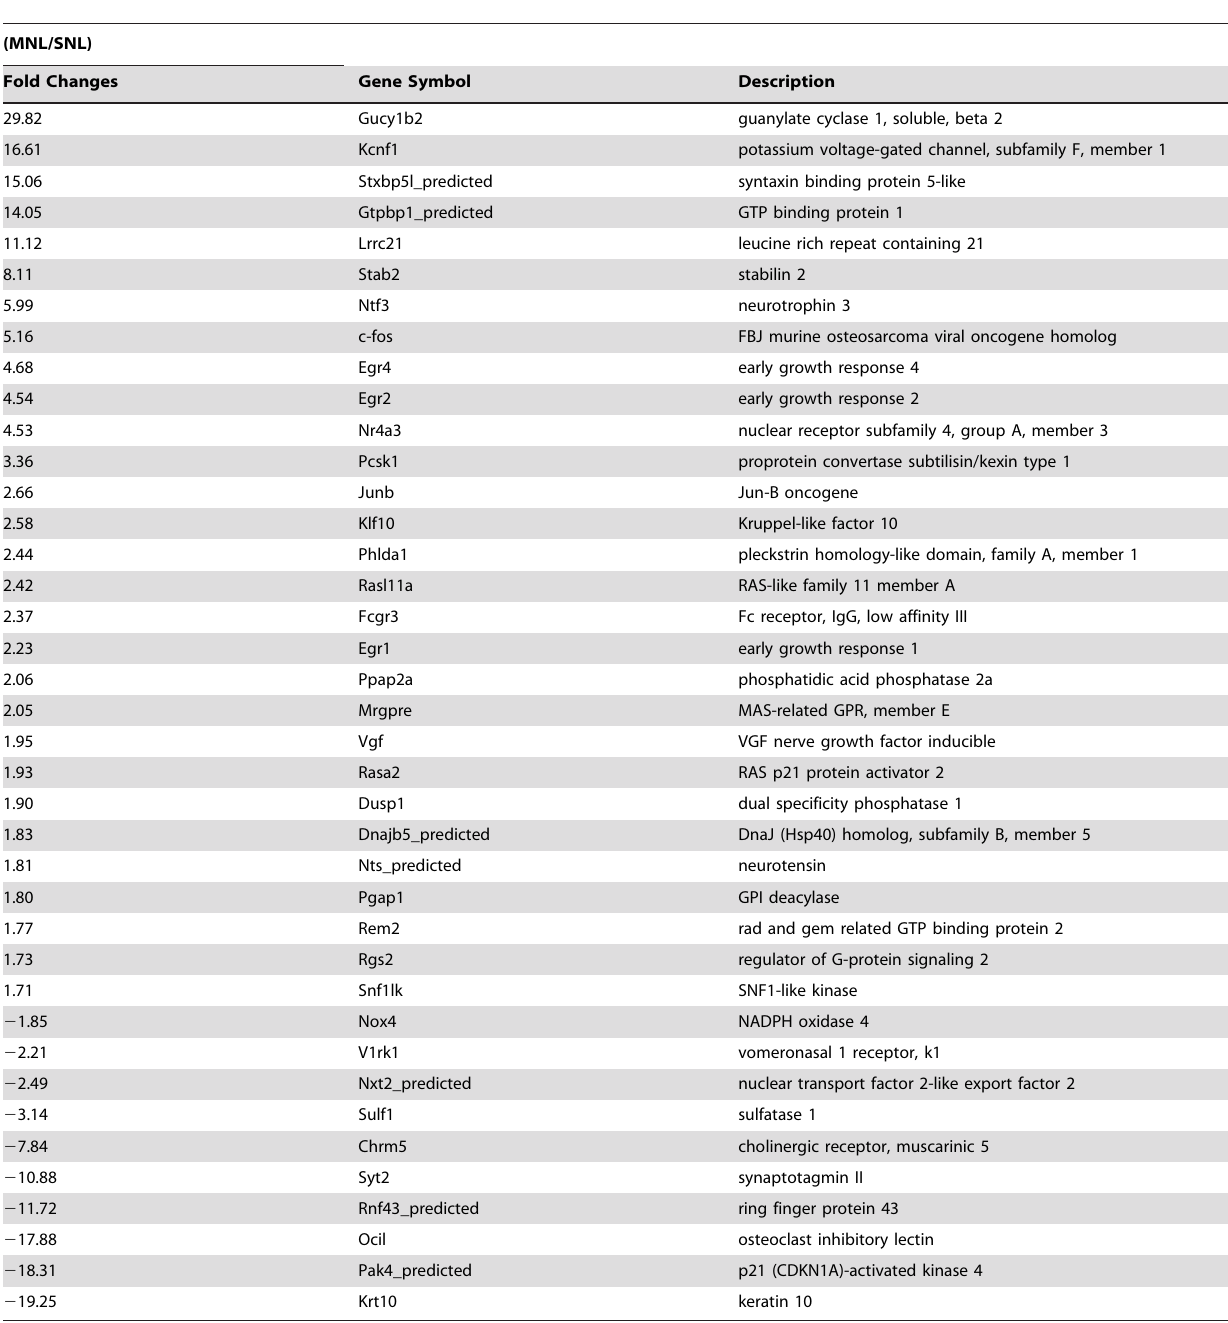
Table 3. Partial list of METH-induced changes in the levels of gene transcripts on the intact striatum of hemiparkinsonian rats.